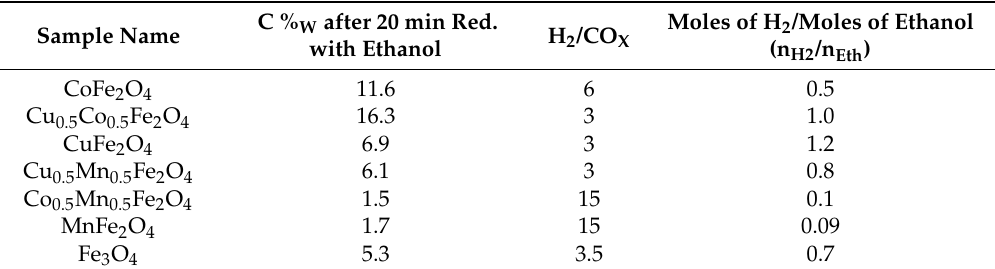
Table 4. Chemical-loop process parameters calculated for MFe 2 O 4 ferrites in bioethanol reforming (note: Listed data correspond to the values obtained after 1 complete cycle of 20